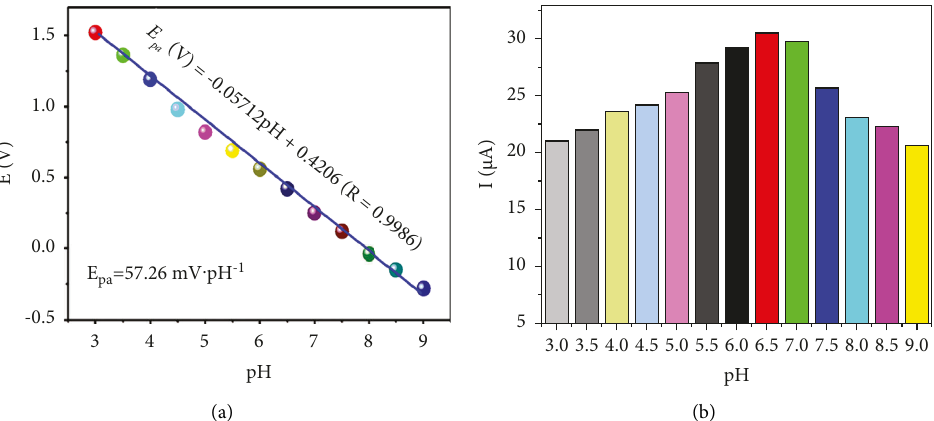
Figure 7: (a) The relationship between pH and the peak potentials. (b) The relationship between pH and the peak currents of HQ (5.0 μ M HQ at 120mV · s − 1 scanning rate).